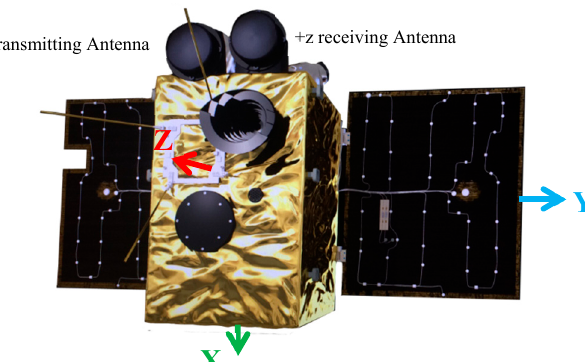
Figure 1. The physical configuration of the Luojia-1A satellite (+z side).